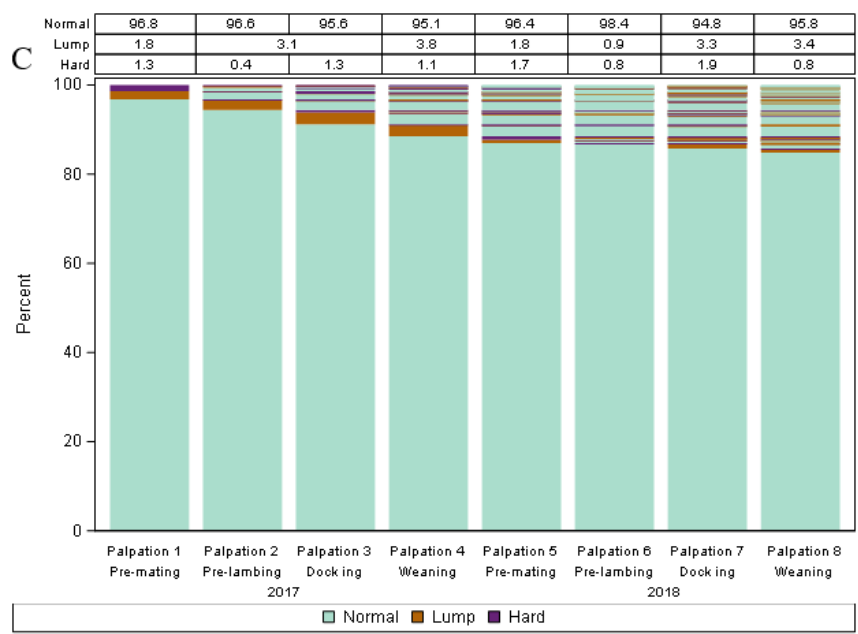
Figure 1. Lasagna plot of palpable udder half defects (hard, lump, and normal) from non ‐ dairy Romney ewes identified during udder examination events occurring at key management times (pre ‐ mating, pre ‐ lambing, docking, and weaning; Study A). ( A ) Lasagna plot of 1860 udder halves (930 ewes) in the year 2017; ( B ) 1428 udder halves (714 ewes) in the year 2018; ( C ) 1408 udder halves (704 ewes) from 2017 and 2018 combined . Note: Within each plot, each bar shows a different udder half scoring event (i.e., time) while the different colours within each bar represent the defect categories. The data in the table at the top of each plot designates the percentage (%) of each udder half defect category at each event, which corresponds to the percentage of each colour at each event. Change in defect category over time of each udder half can be tracked by following longitudinal transitions across the udder scoring events of stacked bars.